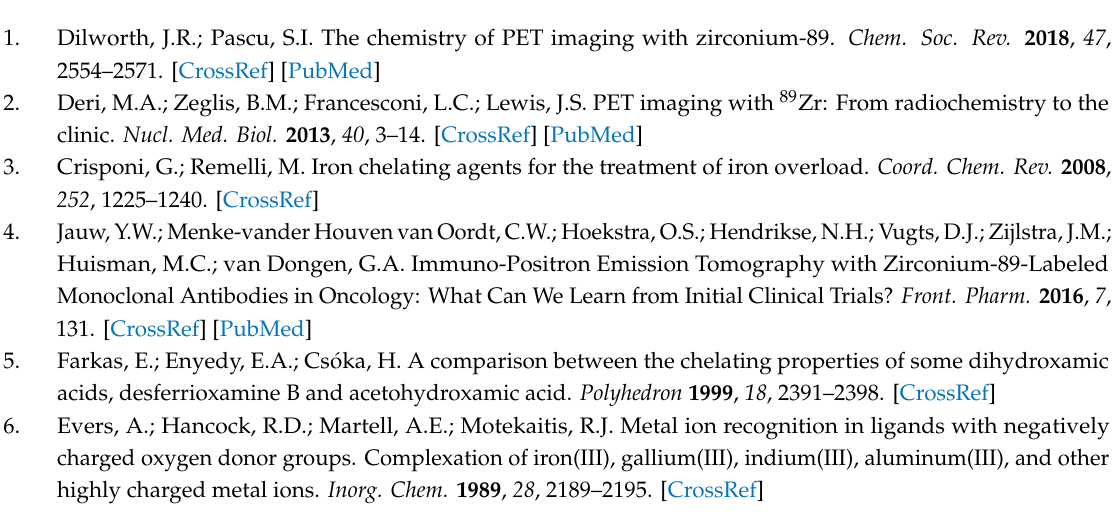
Table S1: equilibrium constants of the complexes formed by Zr 4 + with EDTA, Table S2: equilibrium constants of the complexes formed by Zr 4 + with DFO, Figure S1: distribution diagrams for the Zr 4 + -H 3 DFO system ([Zr 4 + ] = [L] = 1mM) in aqueous